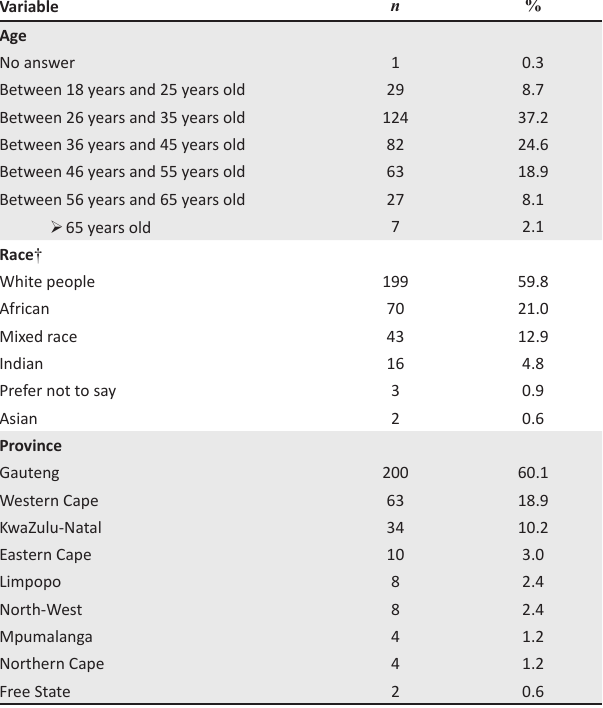
TABLE 2: Demographic profile of respondents.